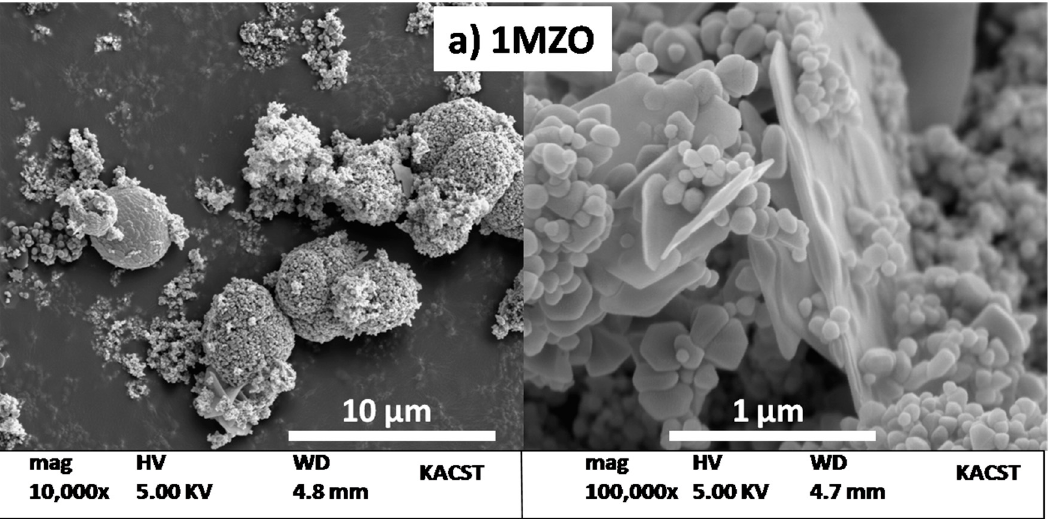
Figure 4. Fitted XRD patterns of ( a ) ZnO, ( b ) 1MZO, ( c ) 5AZO and ( d ) 5A1MZO nanoparticles.